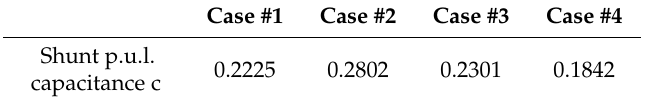
Figure 10. Subdivision of case #4 in elementary cells, minor and major sections. OT—open trefoil with spacing = 0.2 m; F—flat laying with spacing = 0.6 m; T—close trefoil; JC—joint chamber. Table 11. The p.u.l. capacitances of the four cases in µ F / km with multiconductor cell analysis (MCA).